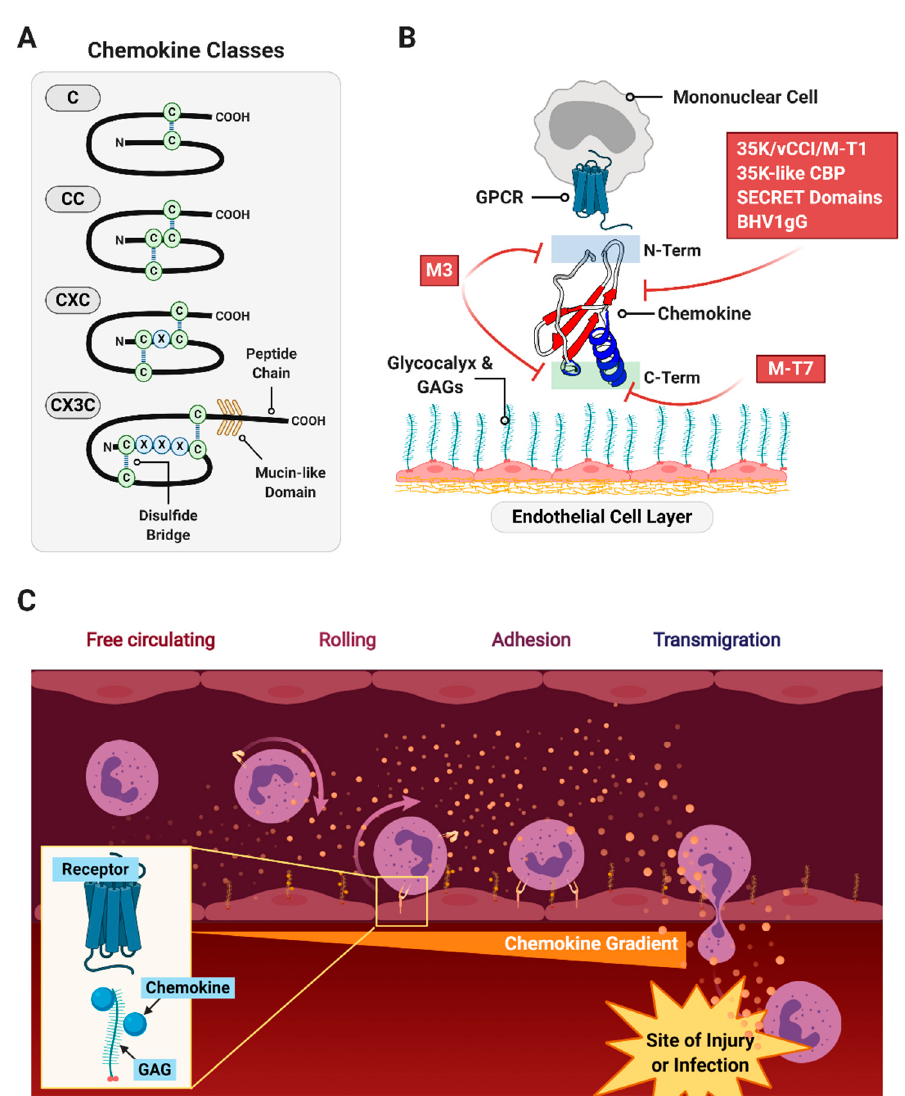
Figure 4. An overview of chemokine function and role. ( A ) Chemokines exhibit highly conserved overall structure with classification by the arrangement of their N-terminal cysteine residues. ( B ) Chemokines bind G protein-coupled receptors (GPCR)-type receptors on chemotactic cells such as mononuclear cells via their N-terminus, and are anchored to tissue matrices and endothelial layers by glycosaminoglycans in the glycocalyx. Viral chemokine signaling modulators are indicated in red boxes with an approximate location of interference indicated. ( C ) Gradients formed by the anchoring of chemokines to the glycocalyx direct circulating immune cells to infiltrate into the site of injury or infection.